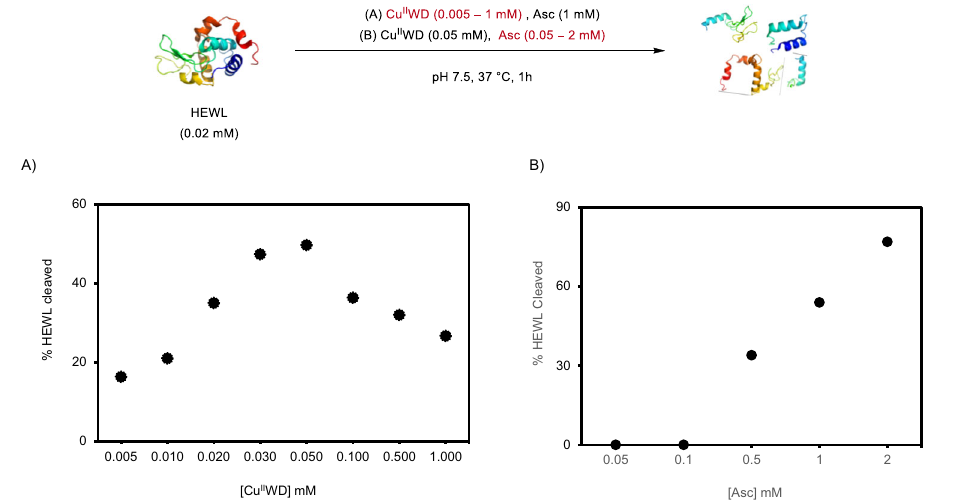
(0.05 – 2.00mM), at pH 7.5 and 37°C for 1h. All experiments were measured two